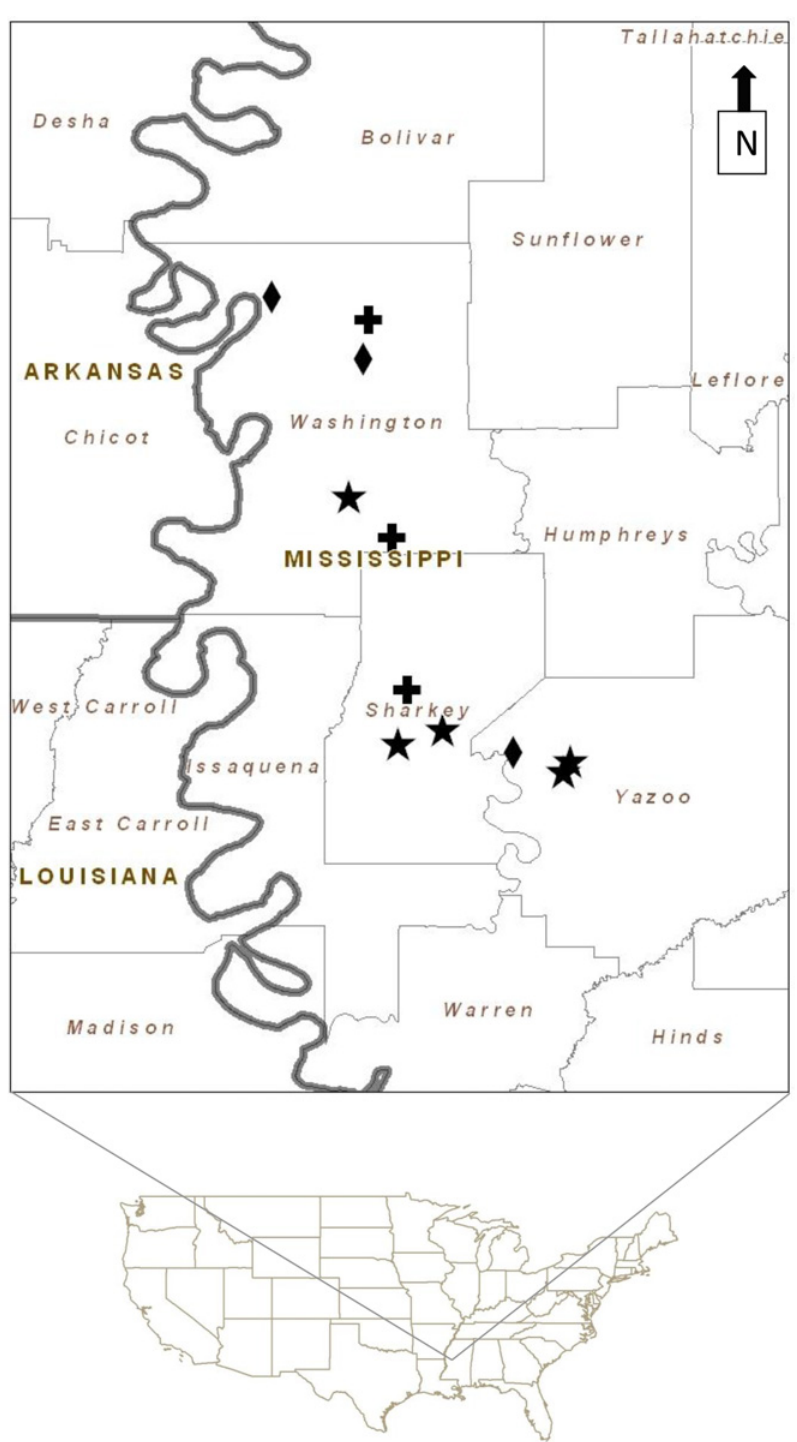
Fig 1. Sampling sites in the Lower Mississippi Alluvial Valley. The location of the study site in the United States is shown (lower part) with sampling sites indicated according to the habitat (upper part). Diamond: Pecan grove locations, cross: creek locations, stars: forest locations; the gray line represents the Mississippi River.